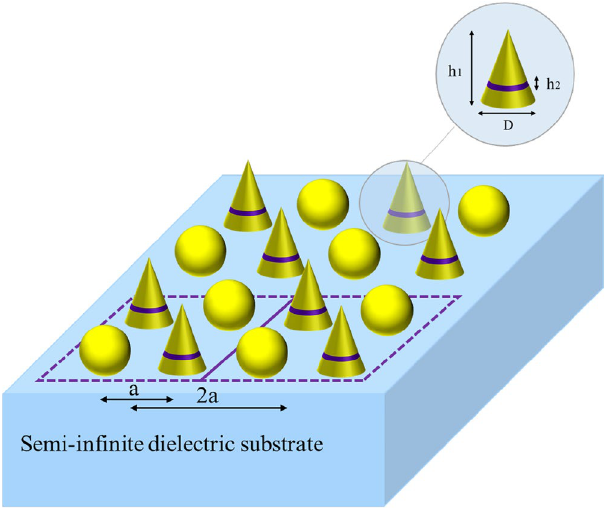
Figure 6. A substrated inhomogeneous metasurface consisting of gold spherical and single-split cone particles. The single- split nanocone, with D = 60 nm , h 1 = 100 nm , h 2 = 20 nm , and the spherical particles with radii of 30 nm.